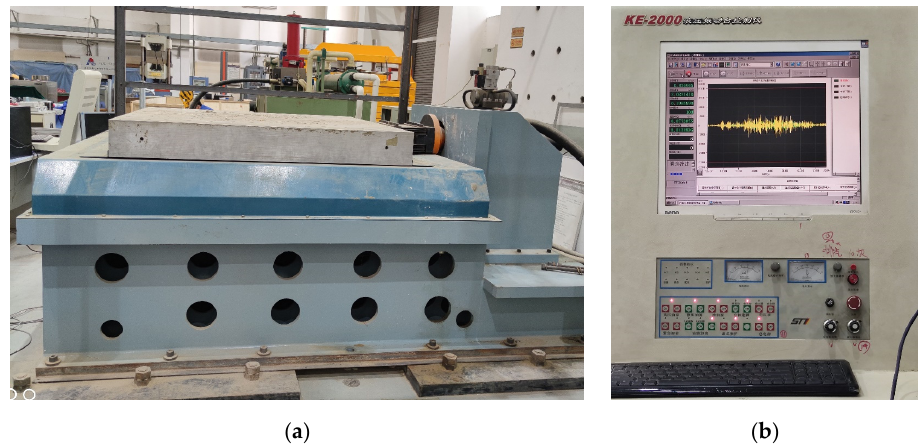
Figure 25. Hydraulic vibration table control equipment: ( a ) Hydraulic vibration table; ( b ) Control equipment.